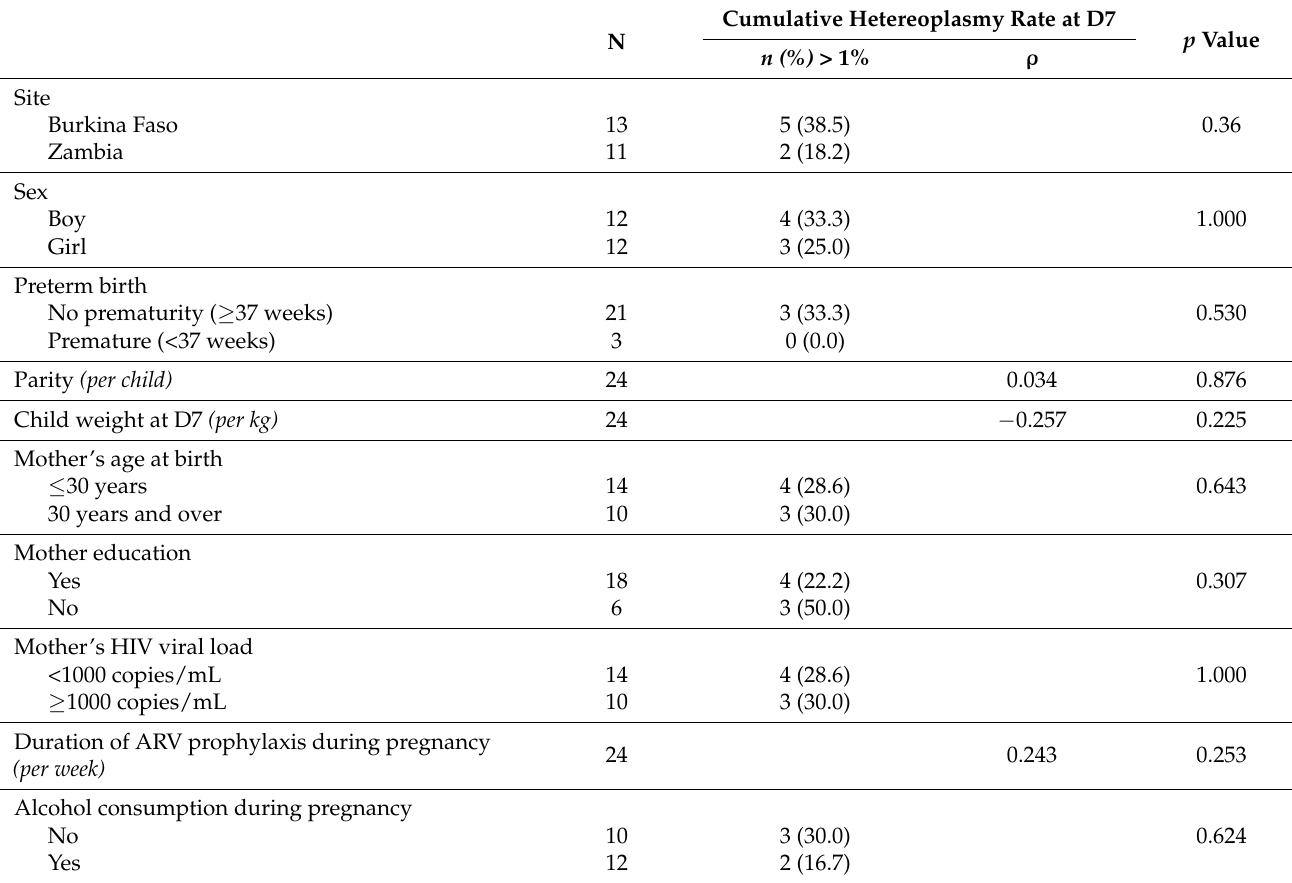
Table 4. Determinants for having an elevated heteroplasmy rate at D7.